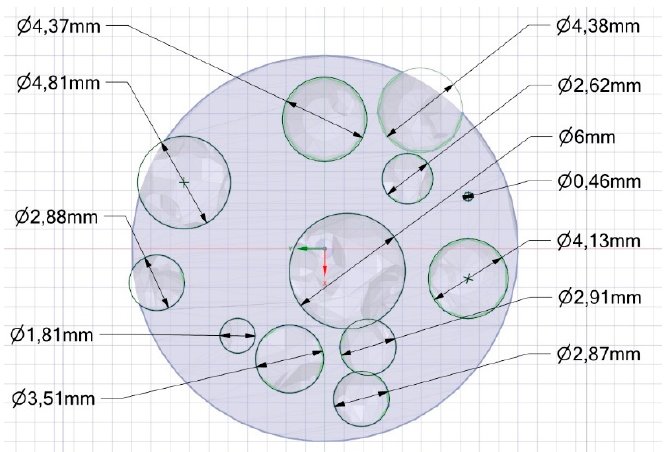
Figure 14. Example of a cross-cut section of the sample foam.